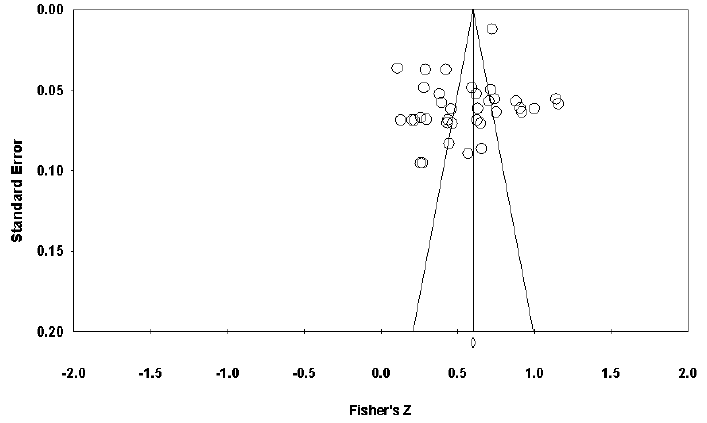
Figure 2. Funnel Diagram of Research on the Search Breadth of Green Resources.